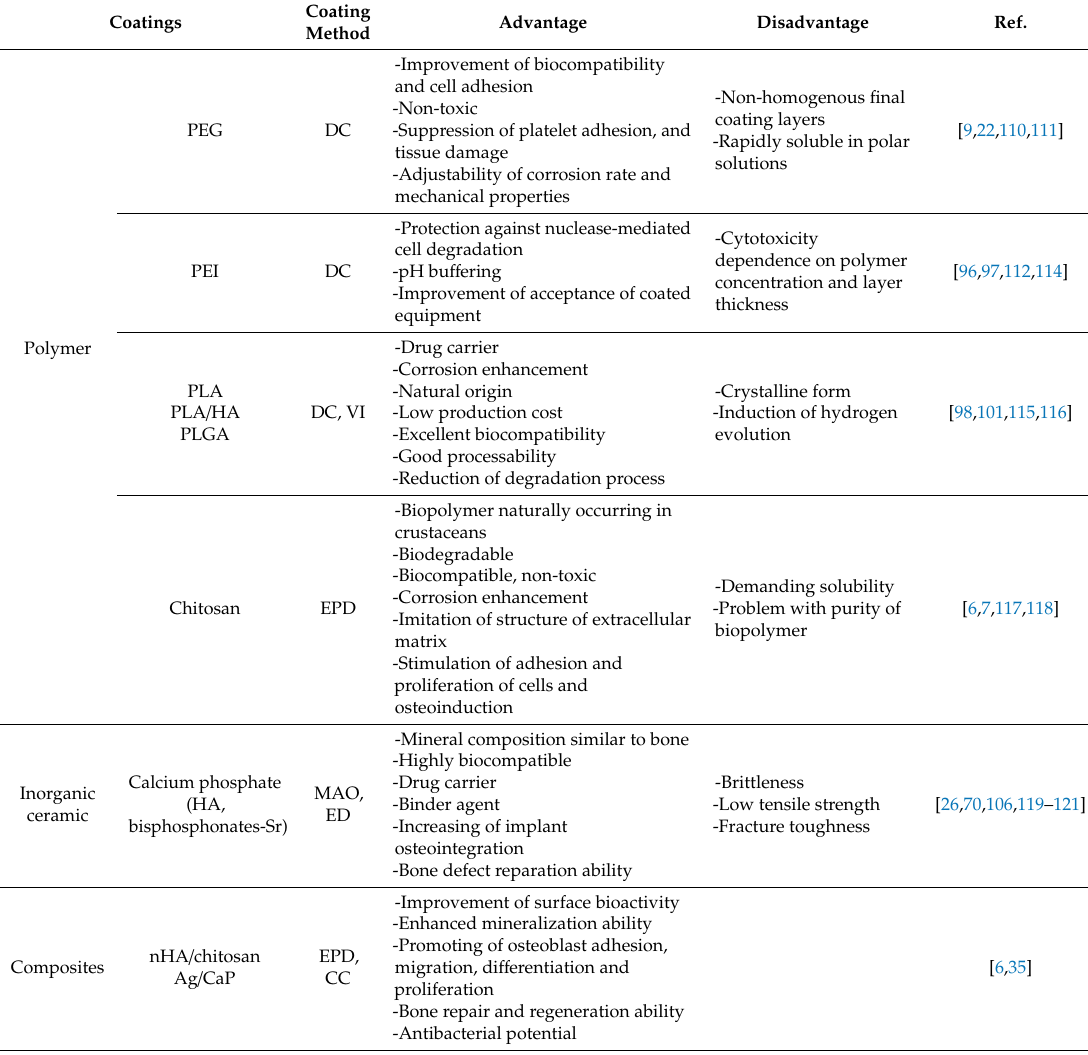
biocompatibility of coated porous metallic materials. Coating Method